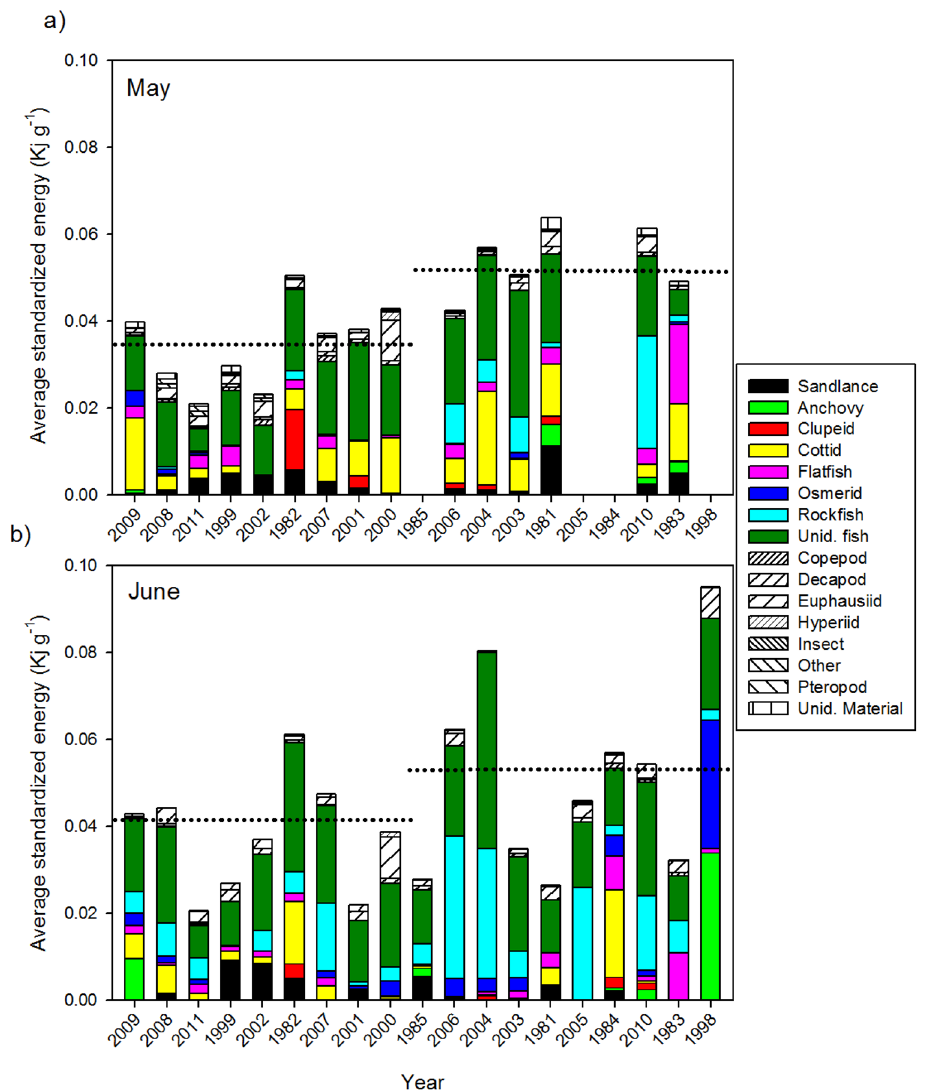
Fig 4. Average standardized prey energy density eaten (kJ g -1 ) by sampling year and May (a) and June (b). The x-axis years are ranked by average spring Pacific Decadal Oscillation (low to high) with cold regime on left of vertical dashed line, and warm regime to the right and with horizontal dotted line representing regime